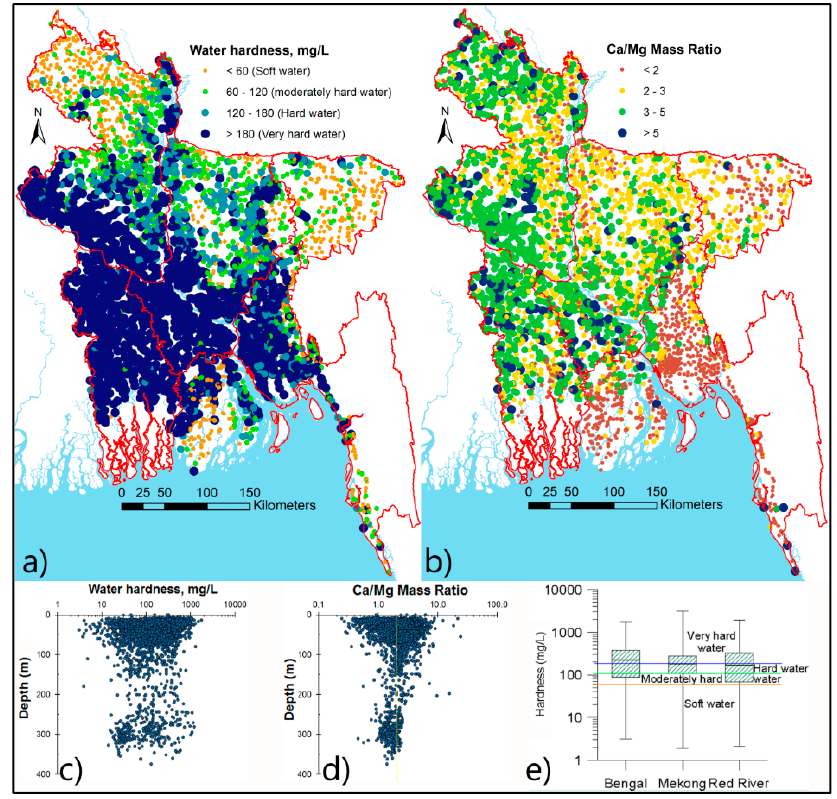
Figure 7. Water hardness and Ca/Mg mass ratio in Bangladesh groundwater. ( a ) Most of the hard or very hard water are found in the southwest region; while ( b ) Ca/Mg mass ratio is above 2 most parts except east and southeast region of the country; ( c ) Hardness of water varies irrespective of the well depths; but ( d ) Ca/Mg ratio is more homogeneous and around 2 in deeper (>100 mbgl) wells contrary to their shallower depths; ( e ) Box plots indicating hardness of water in other Asian deltas.